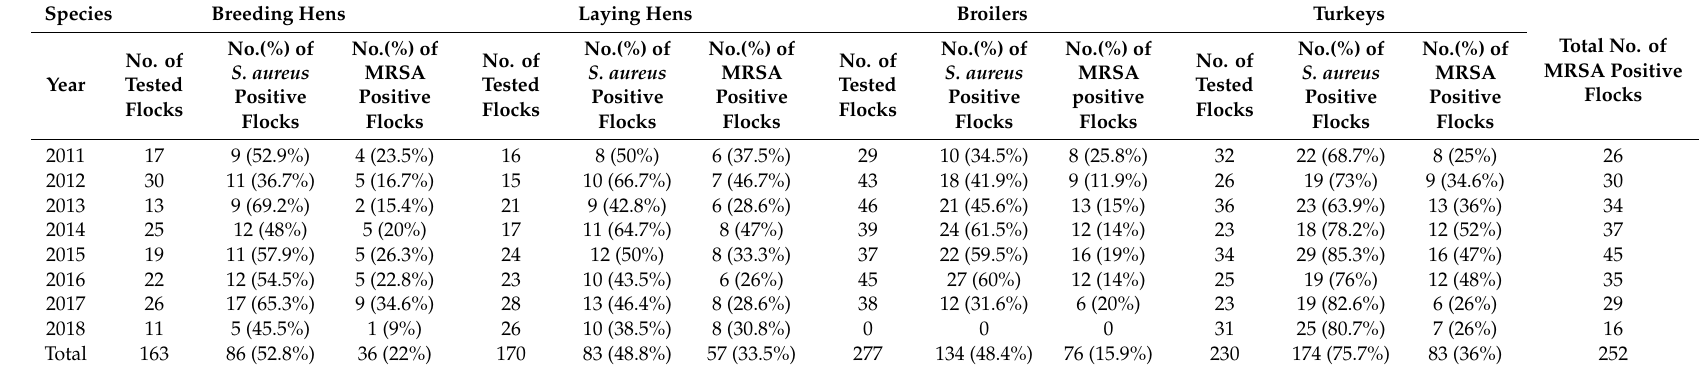
Table 3. Temporal distribution of Staphylococcus aureus and MRSA culture-positive poultry farms in Northern Algeria between from 2011 to 2018. Species Breeding Hens Laying Hens Broilers Turkeys